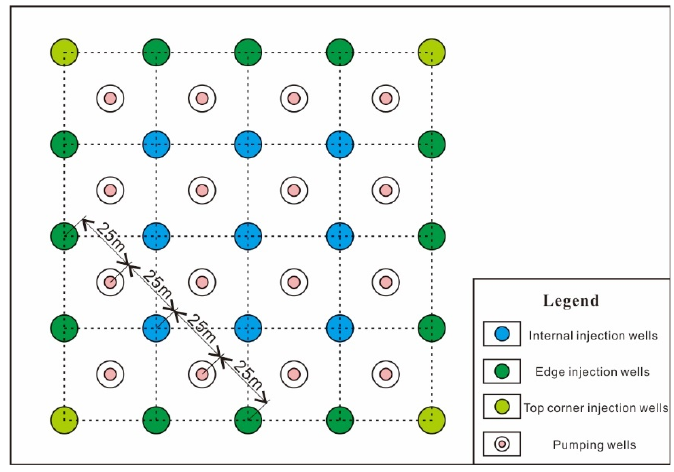
Figure 1. Distribution of injection wells in the in ‐ situ leaching mining area.